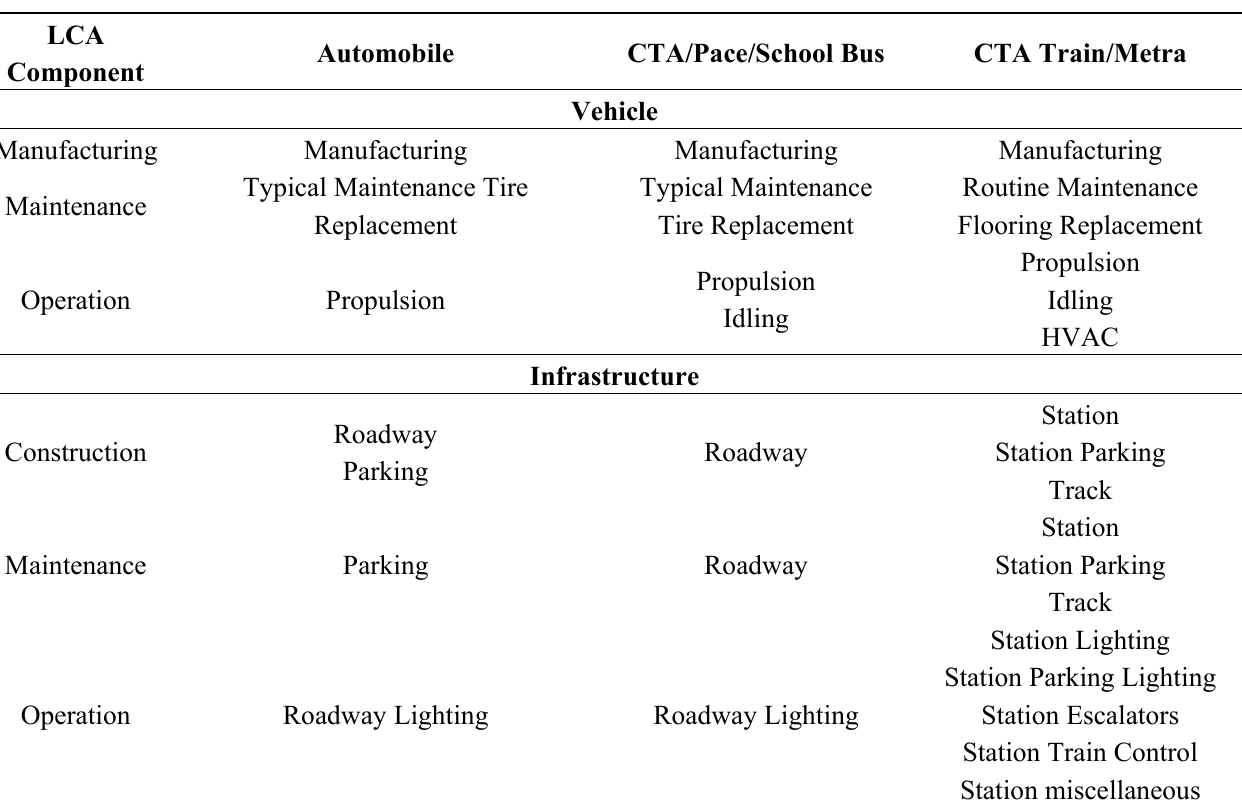
Table 7. Life-cycle assessment of the system boundary. HVAC: Heating, ventilating, and